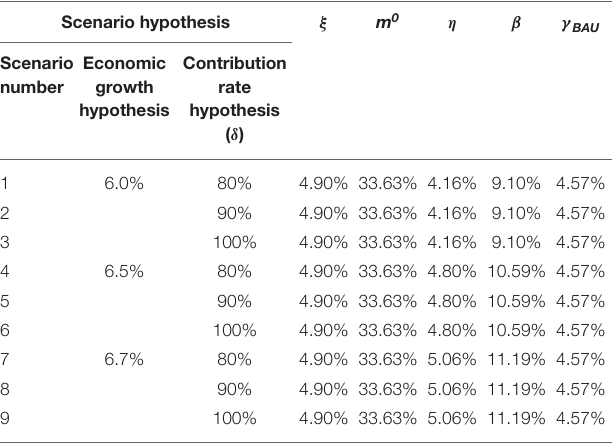
TABLE 2 | Parameters setting of the overall REC